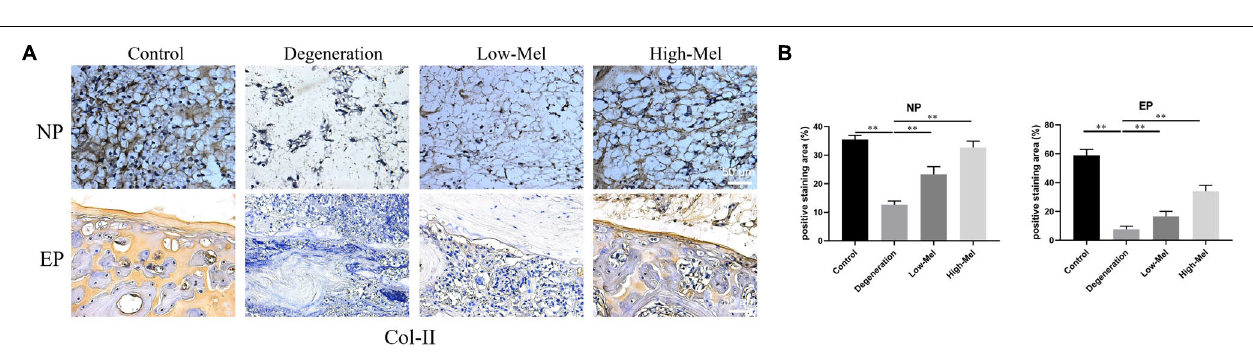
FIGURE 1 | Radiographs and histological analysis of intervertebral disks (IVDs) in the rat intervertebral disk degeneration (IVDD) model. (A) X-ray photographs and MRI scans of IVDs on the 7th day after puncture injury. (B) The change in %DHI over time among groups. (C) MRI grading for all groups over time. (D) H&E staining and safranin-O staining. (E) Histological score on the 7th, 14th, 21st, and 28th days after puncture injury ( n = 5, ∗ P < 0.05, ∗∗ P < 0.01).